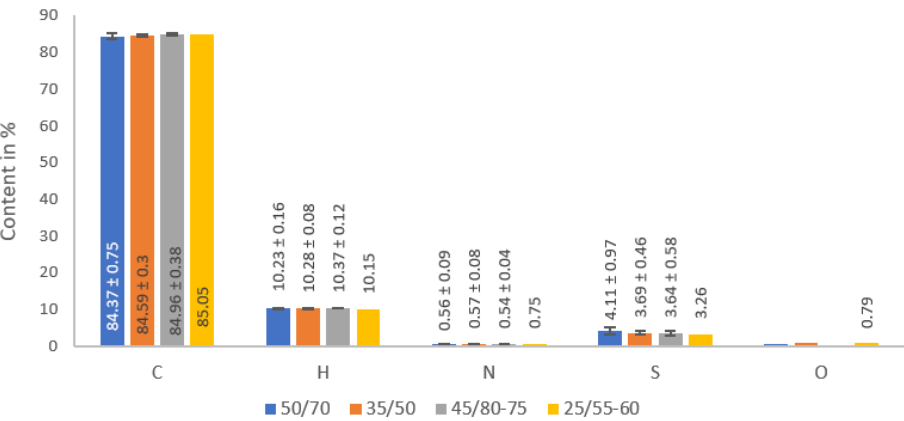
Figure 2. Elemental analysis (CHNS and O content) results of tested bitumen samples.